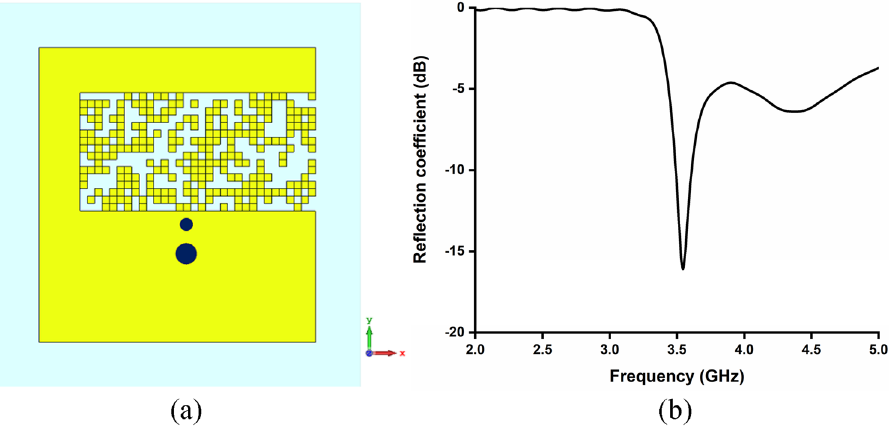
Figure 6. ( a ) Pixelated layout of Antenna A (3.5 GHz), Software used: CST Microwave Studio 2019, https:// www. 3ds. com/ produ cts- servi ces/ simul ia/ produ cts/ cst- studio- suite/ ( b ) reflection coefficient of Antenna A.